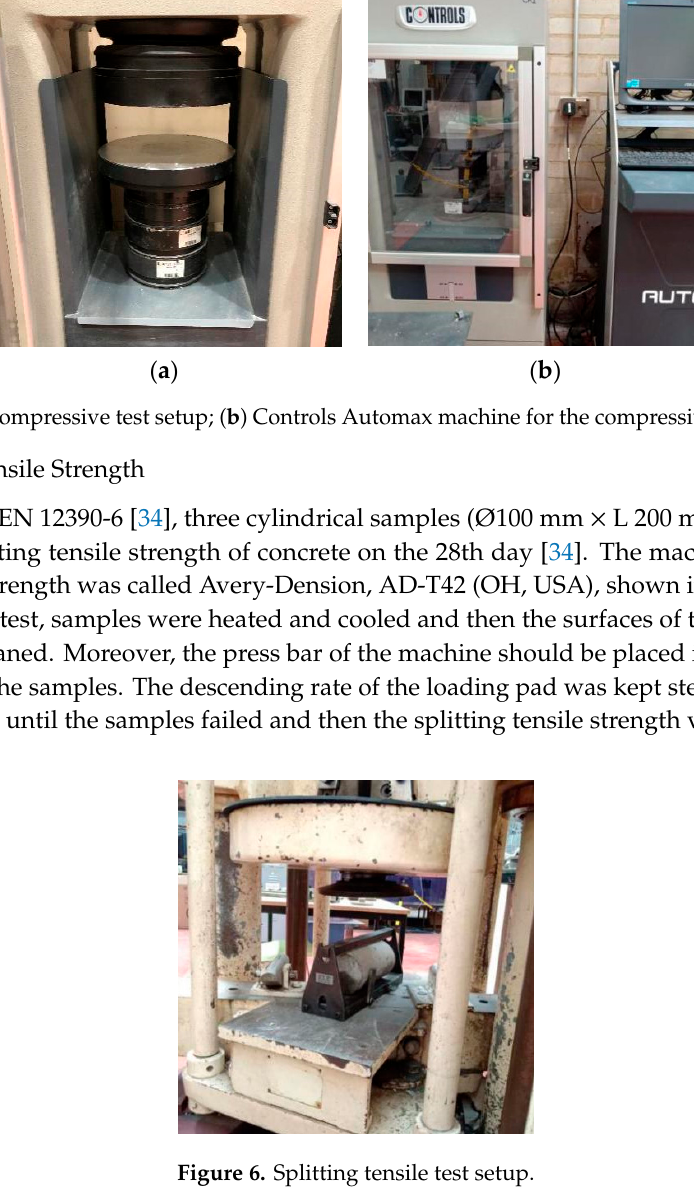
Figure 6. Splitting tensile test setup.